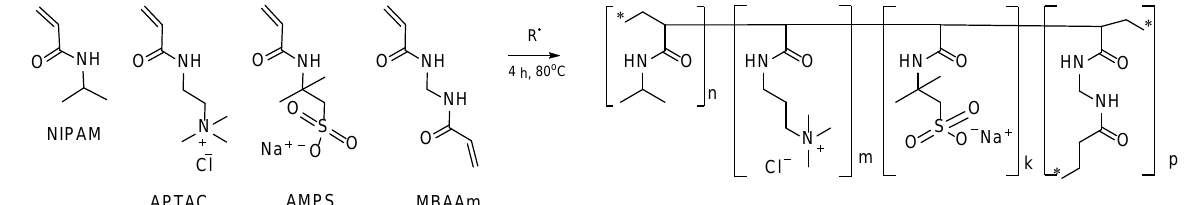
Figure 1. Schematic representation of free radical copolymerization of NIPAM, APTAC and AMPS monomers for nanogel synthesis.